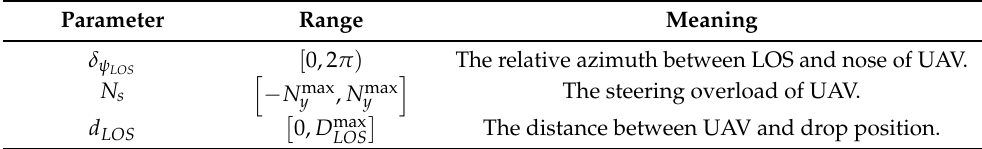
Table 1. The details of data input into networks.